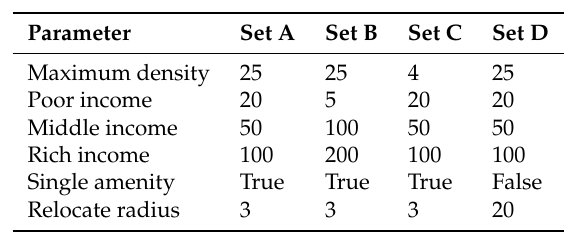
Table 4. Parameter values for each set of exploratory simulations. Set A is the baseline with moderate values, Set B represents high income inequality, Set C represents low density, and Set D represents dispersed natural amenities and wide relocation search radii. The values of the parameters held constant appear in Table